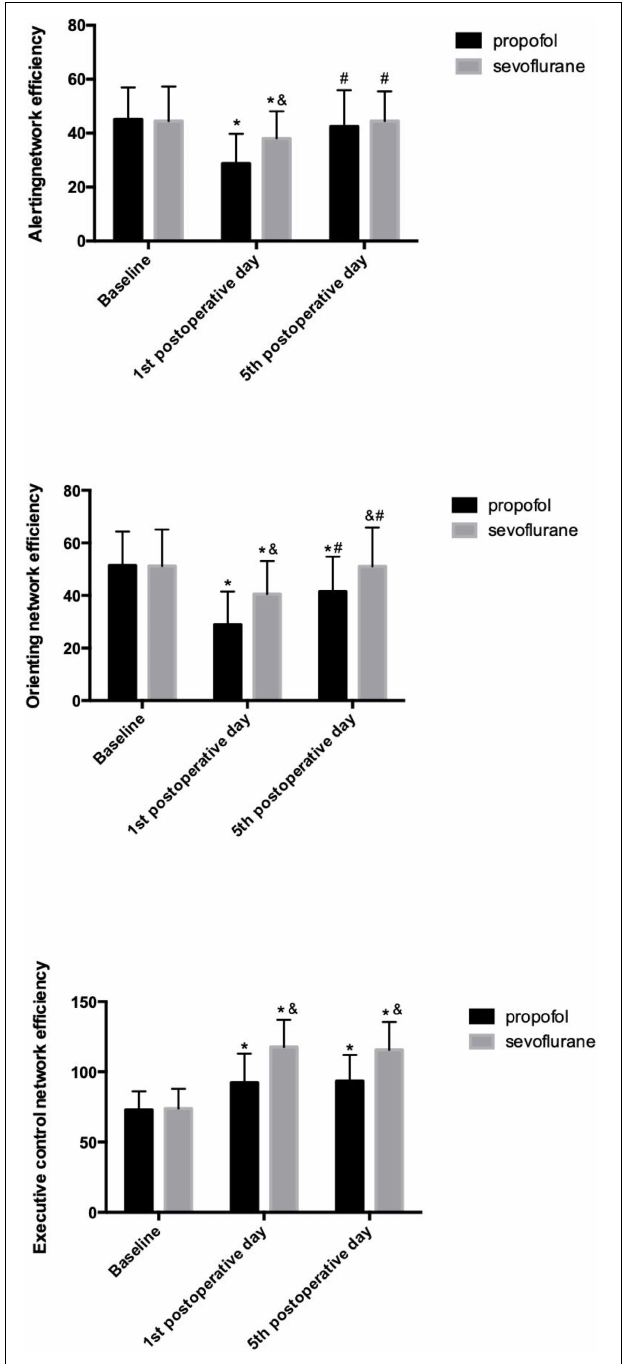
FIGURE 2 | Efficiency of the three attention networks in the propofol and sevoflurane groups. * p < 0.05 versus baseline values; # p < 0.05 versus 1st postoperative day; & p < 0.05 versus the propofol